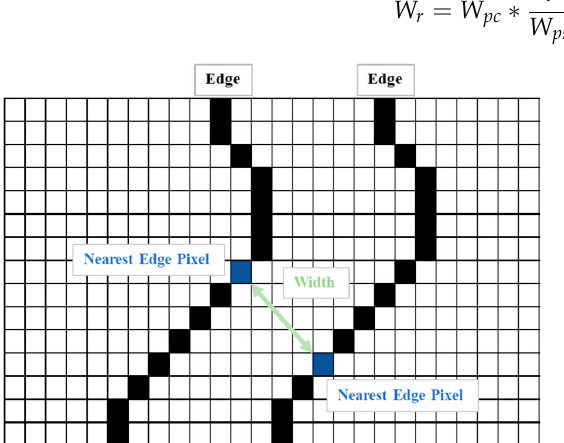
Figure 11. Crack measurement.